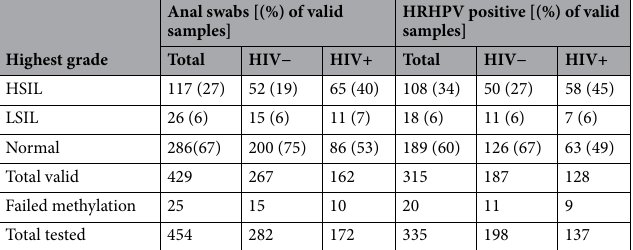
Table 1. Samples included in analysis categorised by composite disease grade.